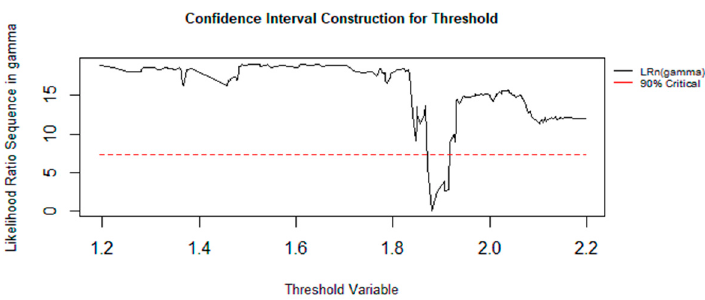
Figure 3. Threshold estimator diagram for Model 2. Note: authors’ calculation. Table 4. Dynamic panel threshold estimates for Model 2.